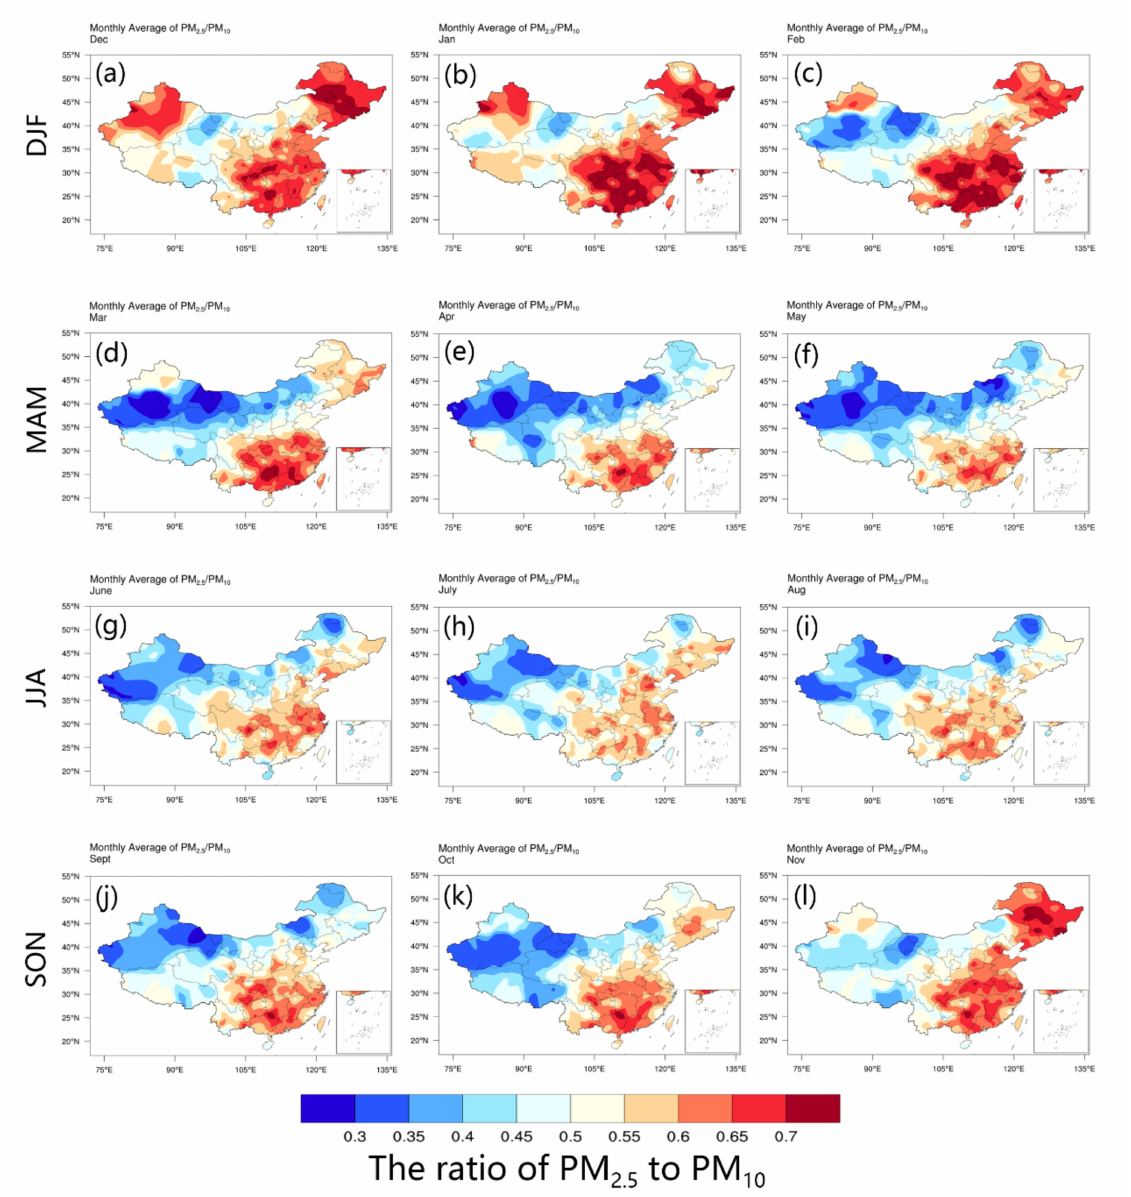
Figure 4. The spatial distributions of PM 2.5 /PM 10 in ( a – c ) winter (DJF), ( d – f ) spring (MAM), ( g – i ) summer (JJA), and ( j – l ) autumn (SON) during